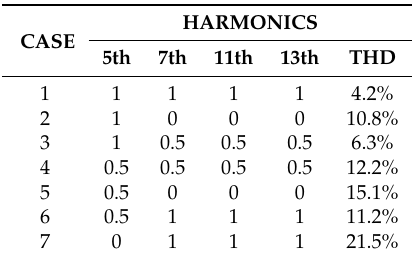
Table 2. Study cases for selective harmonic compensation.